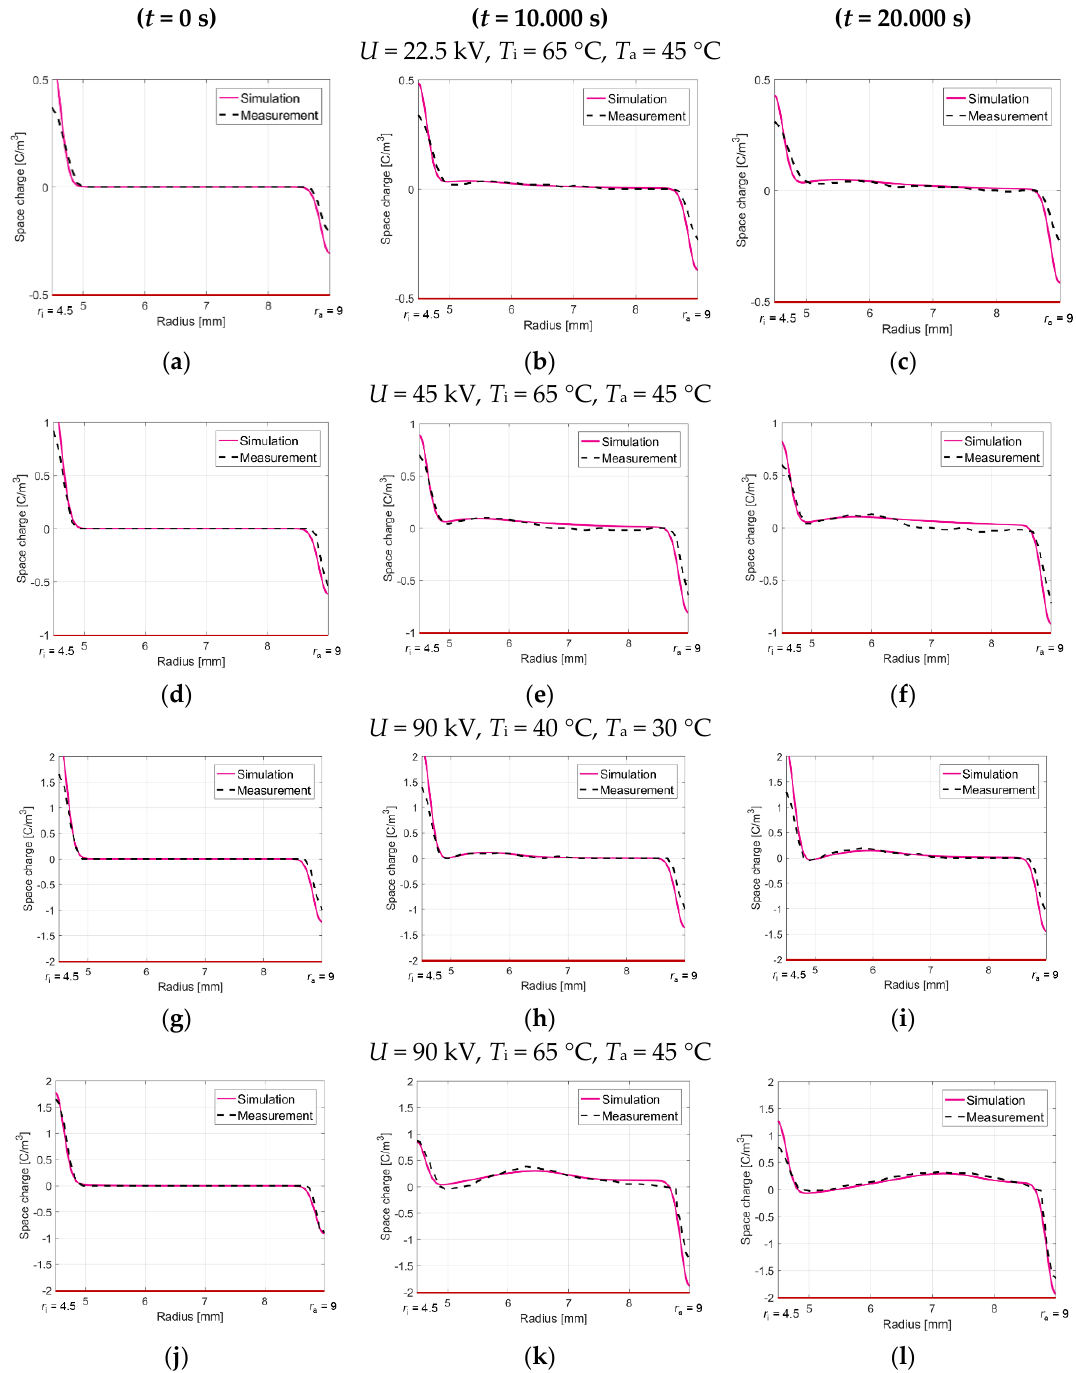
Figure 19. Comparison between a measured (dashed line) and simulated (solid line) space charge distribution within a medium voltage (MV) XLPE cable insulation. ( a ) t = 0 s, U = 22.5 kV; ( b ) t = 10,000 s, U = 22.5 kV; ( c ) t = 20,000 s, U = 22.5 kV; ( d ) t = 0 s, U = 45 kV; ( e ) t = 10,000 s, U = 45 kV; ( f ) t = 20,000 s, U = 45 kV; ( g ) t = 0 s, U = 90 kV, T i = 40 °C, T a = 30 °C; ( h ) t = 10,000 s, U = 90 kV, T i = 40 °C, T a = 30 °C; ( i ) t = 20,000 s, U = 90 kV, T i = 40 °C, T a = 30 °C; ( j ) t = 0 s, U = 90 kV, T i = 65 °C, T a = 45 °C; ( k ) t = 10,000 s, U = 90 kV, T i = 65 °C, T a = 45 °C; ( l ) t = 20,000 s, U = 90 kV, T i = 65 °C, T a = 45 °C [14,95].